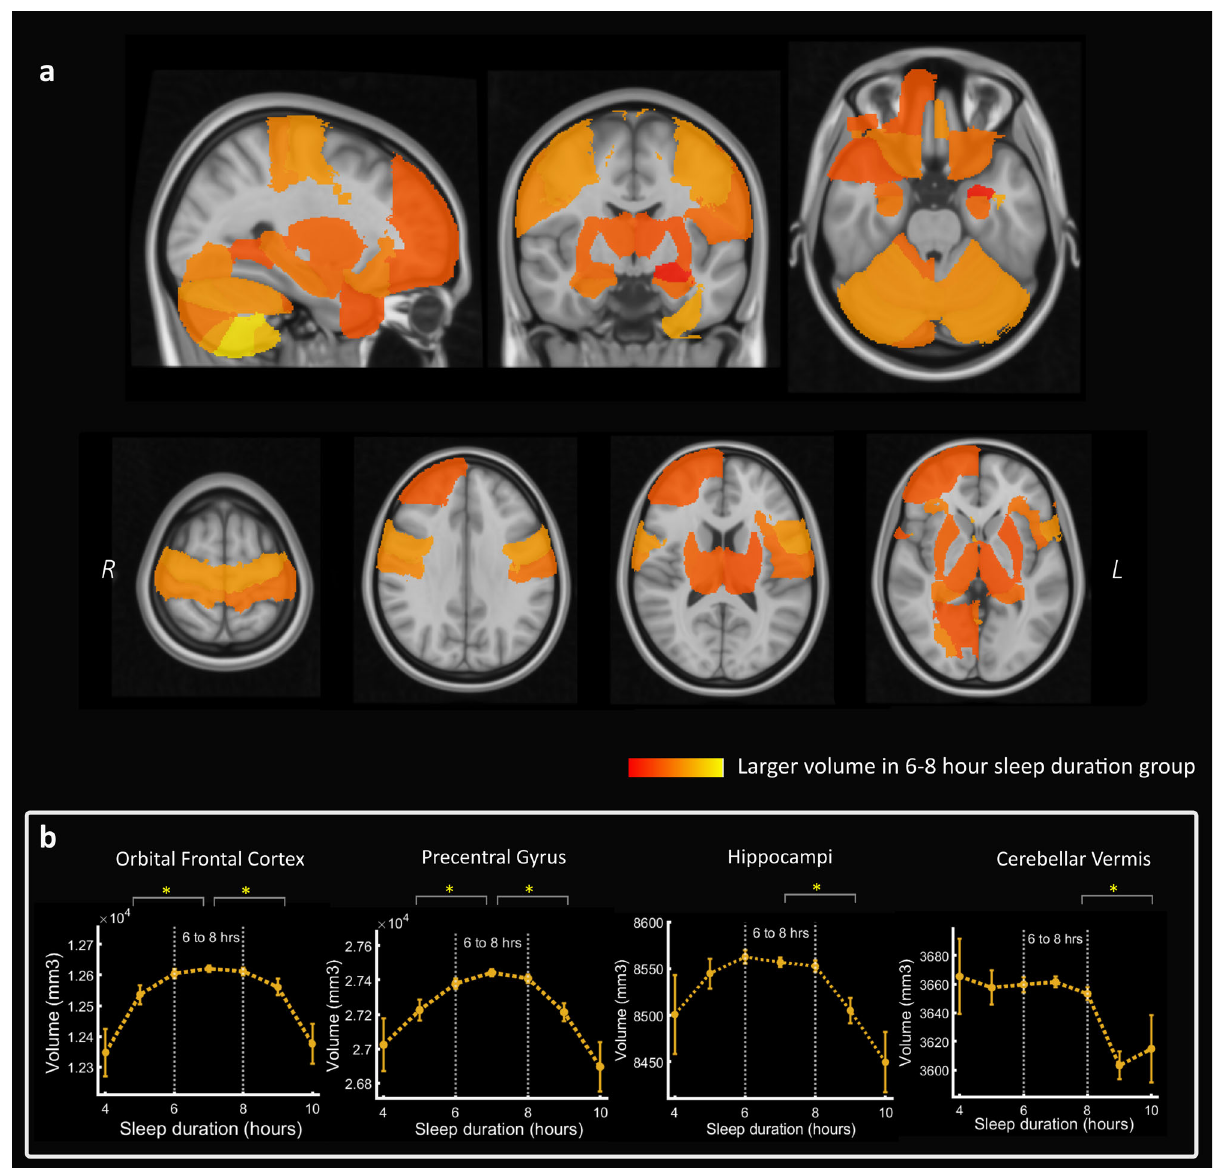
Fig. 3 Brain regions with a larger volume in individuals who reported six-to-eight hours sleep duration compared to other sleep lengths. a Volumetric maps showing that 46 out of 139 cortical and subcortical brain regions (based on the Harvard-Oxford atlas) were associated with a signi fi cantly higher brain volume in imaging participants who slept between six and eight hours per night compared to other durations ( P < 0.05 after Bonferroni correction for multiple comparisons). Several frontal, temporal, parietal and cerebellar regions were identi fi ed including the orbital frontal cortex, pre- and post-central gyrus, hippocampi, thalami, right frontal pole and anterior parahippocampal gyrus. No brain regions were smaller in the six-to-eight hour sleep duration group. Colormap re fl ects proportional volume change. b Relationship between sleep duration and volume in four selected brain regions showing lower volume associated with both sleep duration extremes for some regions whereas others showed a smaller volume mainly with longer sleep durations (signi fi cant difference between sleep group six-to-eight hours compared to less than six or greater than eight hours, * p < 0.05 after Bonferroni correction for multiple comparisons, sleep durations with more than 100 imaging participants are plotted). Boxplots for Fig. 3b shown in Supplementary Fig